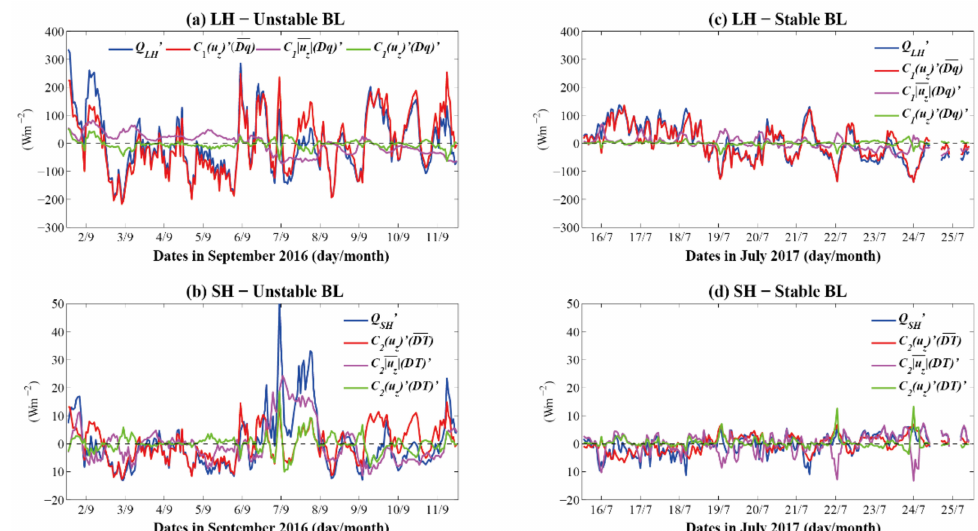
Figure 17. The hourly variations of the terms in Equations (14) and (15). ( a ): the time series of the anomalies of the Q LH (term A in Equation (14), dark blue), the anomalies of Q LH induced by wind anomalies (term B in Equation (14), red) and air-sea humidity difference anomalies (term C in Equation (14), magenta) and the nonlinear term (term D in Equation (14), green) under unstable BLSs in September of 2016. ( b ): the same as in ( a ) but for anomalies of the Q SH and associated terms. ( c ) and ( d ) are the same as in ( a , b ), but for anomalies under stable BLSs in July of 2017. The results for the Q SH anomalies were different from those of the Q LH